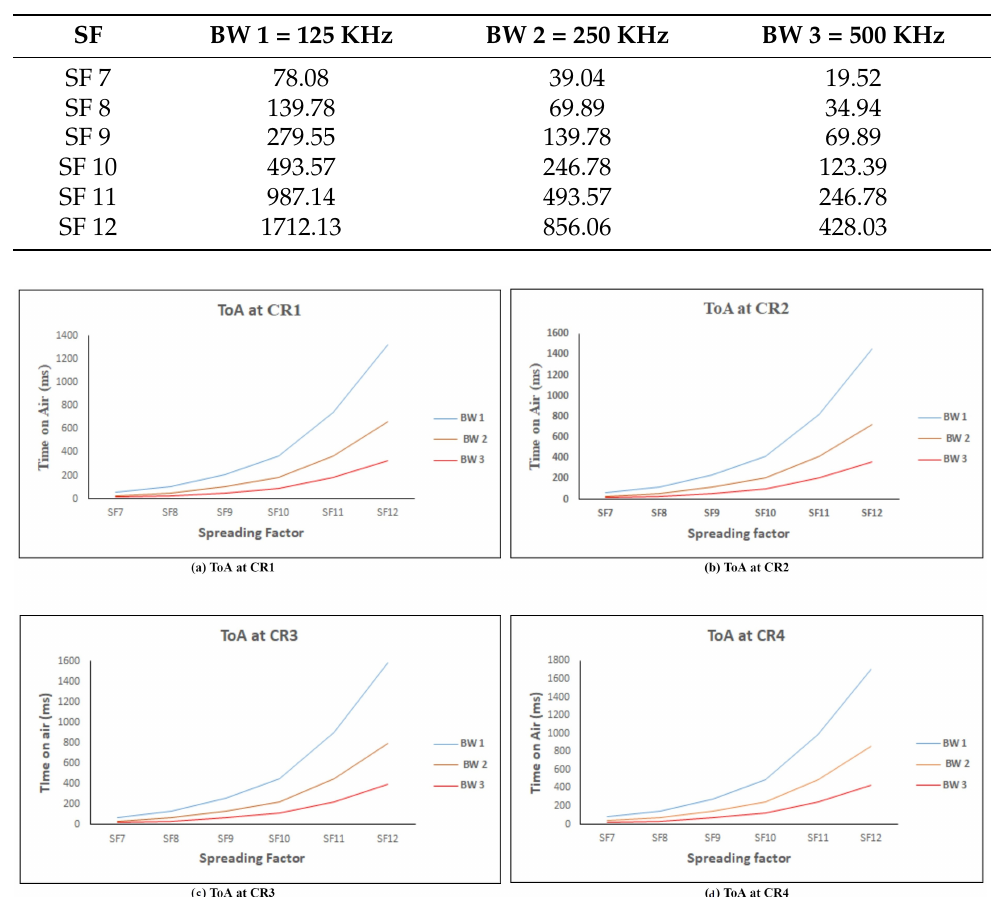
Table 11. ToA (ms) at CR 4.